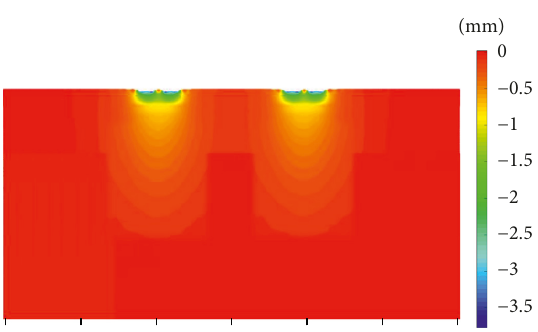
Figure 12: The computational vertical displacement (mm) with a scale factor of